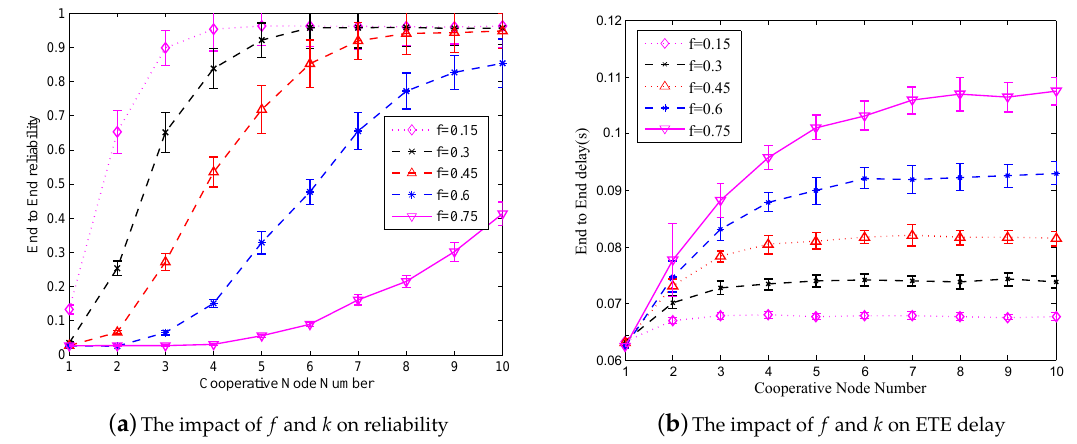
( b ) The impact of f and k on ETE delay Figure 7. The impact of f and k on reliability and ETE delay in RCR.